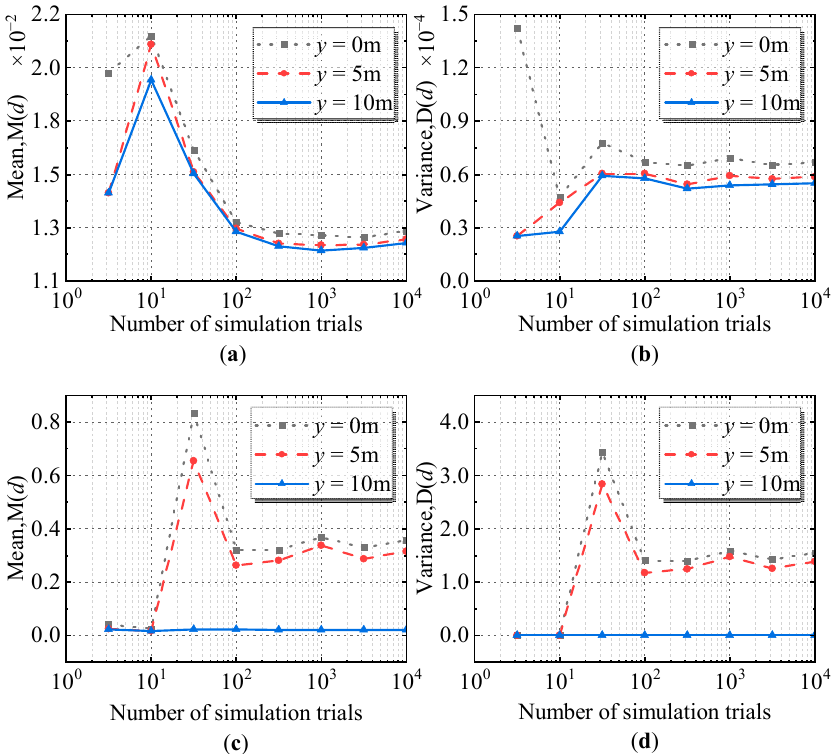
Figure 7. The expectation and variance of the main peak position error at the three conductors ( d = 0.05m): ( a ) Expectation M ( d ) of the main peak position error at the second-order di ff erential; ( b ) Variance D ( d ) of the main peak position error at the second-order di ff erential; ( c ) Expectation M ( d ) of the main peak position error at the fourth-order di ff erential; ( d ) Variance D ( d ) of the main peak position error at the fourth-order di ff erential.